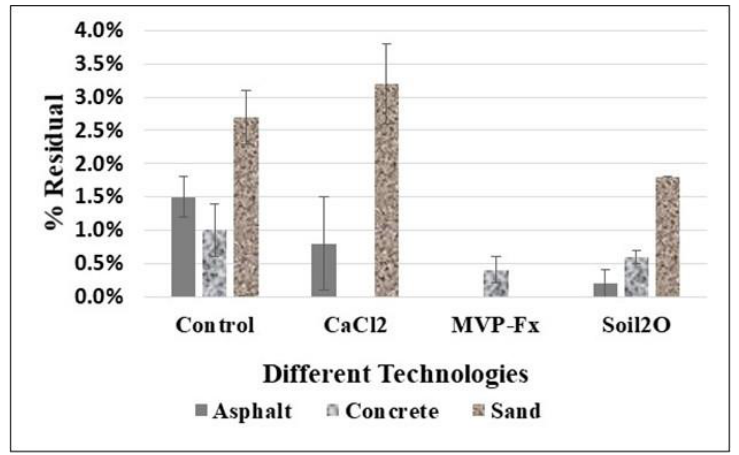
Figure 16. Percent Residual of Sr-85 Contaminated Particles from Foot Traffic Experiments.